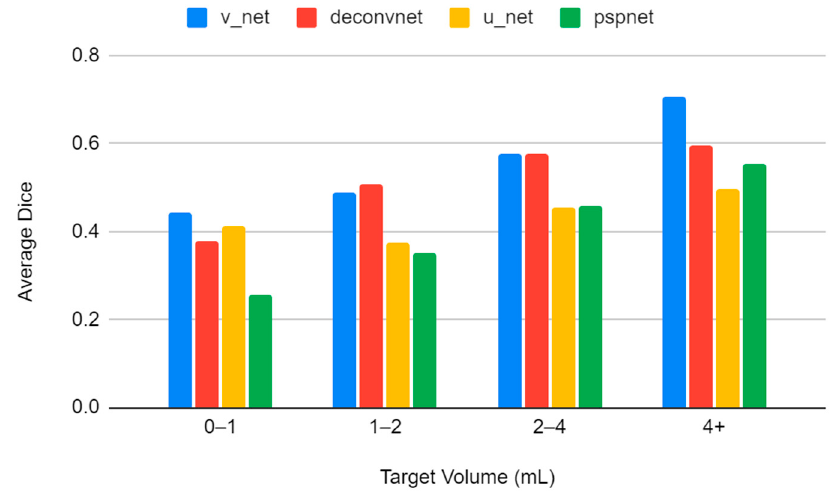
Figure 2. The performance of each model on lesions within different volume ranges.